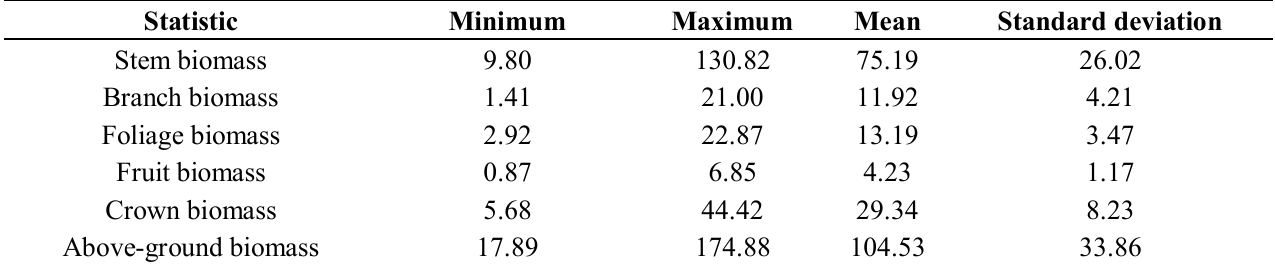
Table 1. Characteristics of above-ground biomass (Mg·ha −1 ) and biomass components for in-situ measured plots.